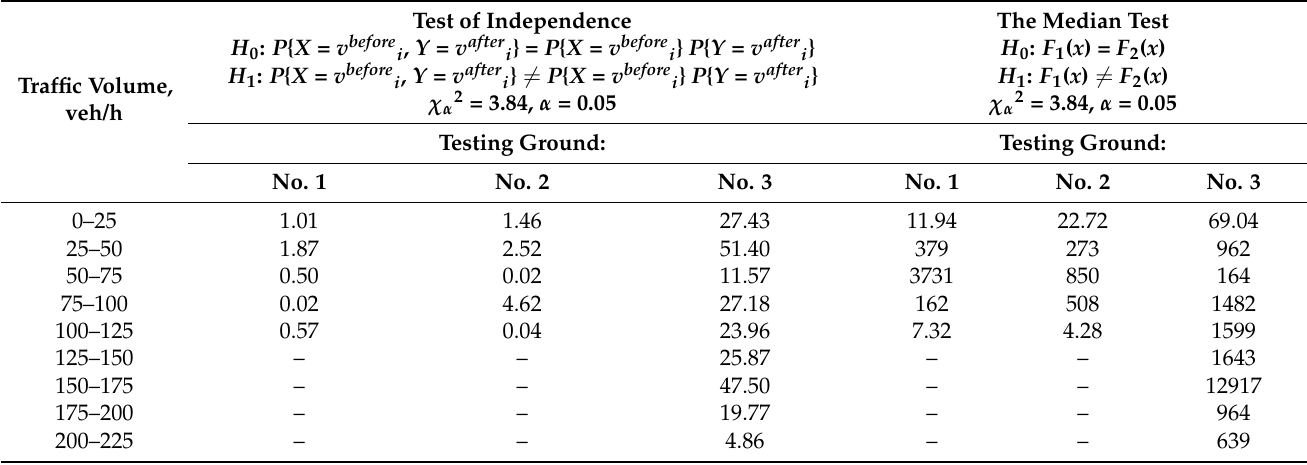
Table A3. Results of the test of independence and median